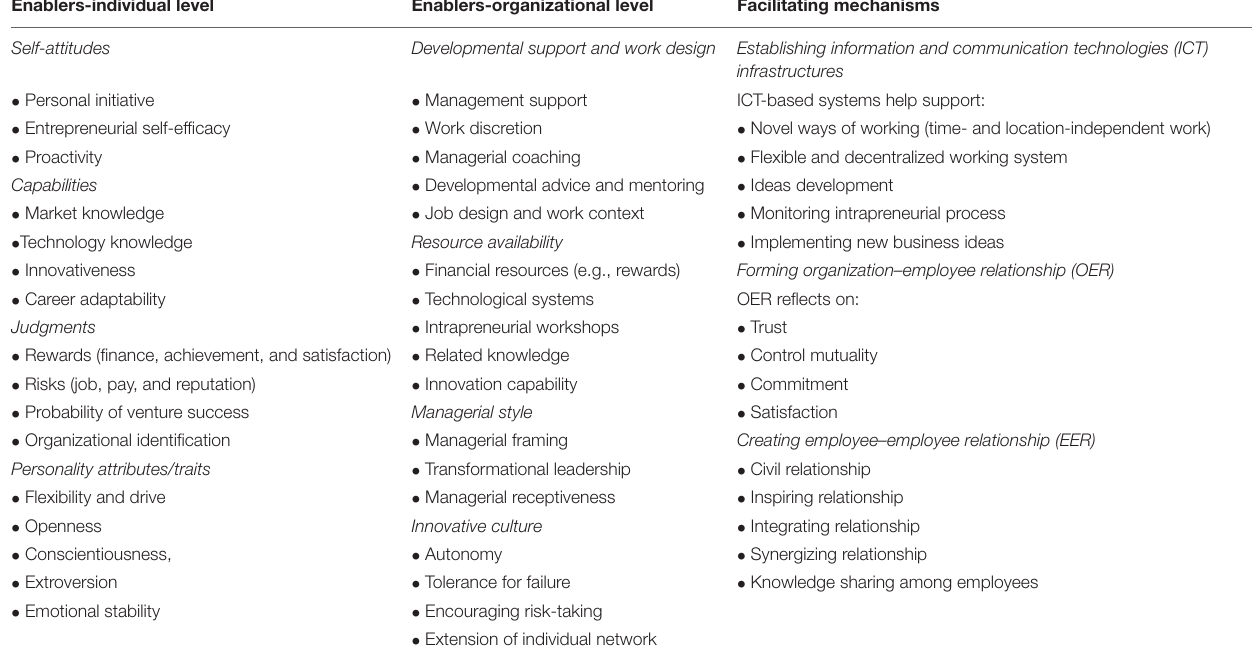
TABLE 2 | Summary of enablers (individual and organizational level) and facilitating mechanisms for cultivation of intrapreneurship. Enablers-individual